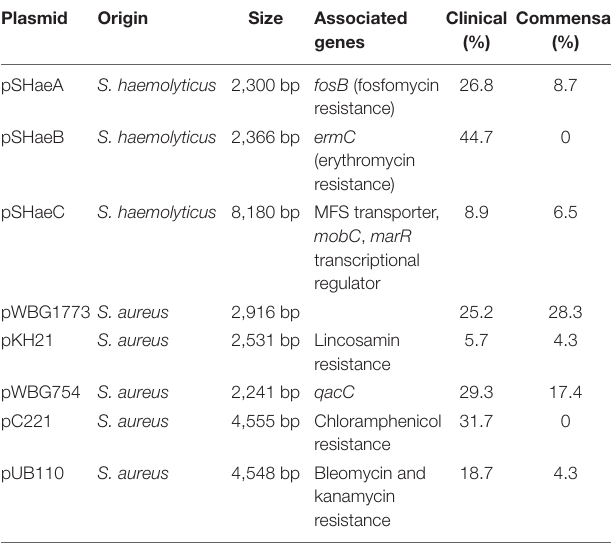
TABLE 2 | Smaller plasmids and their distribution in clinical ( n = 123) and commensal ( n = 46) isolates.